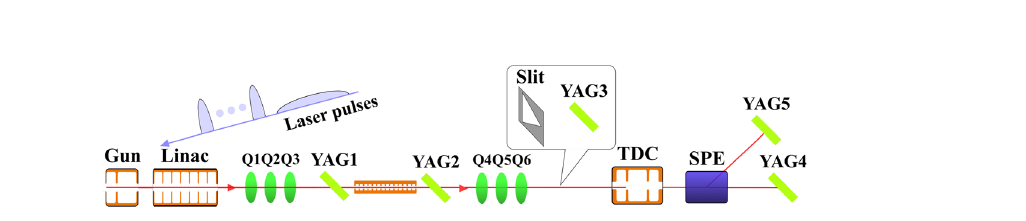
Figure 4. Schematic diagram of experimental